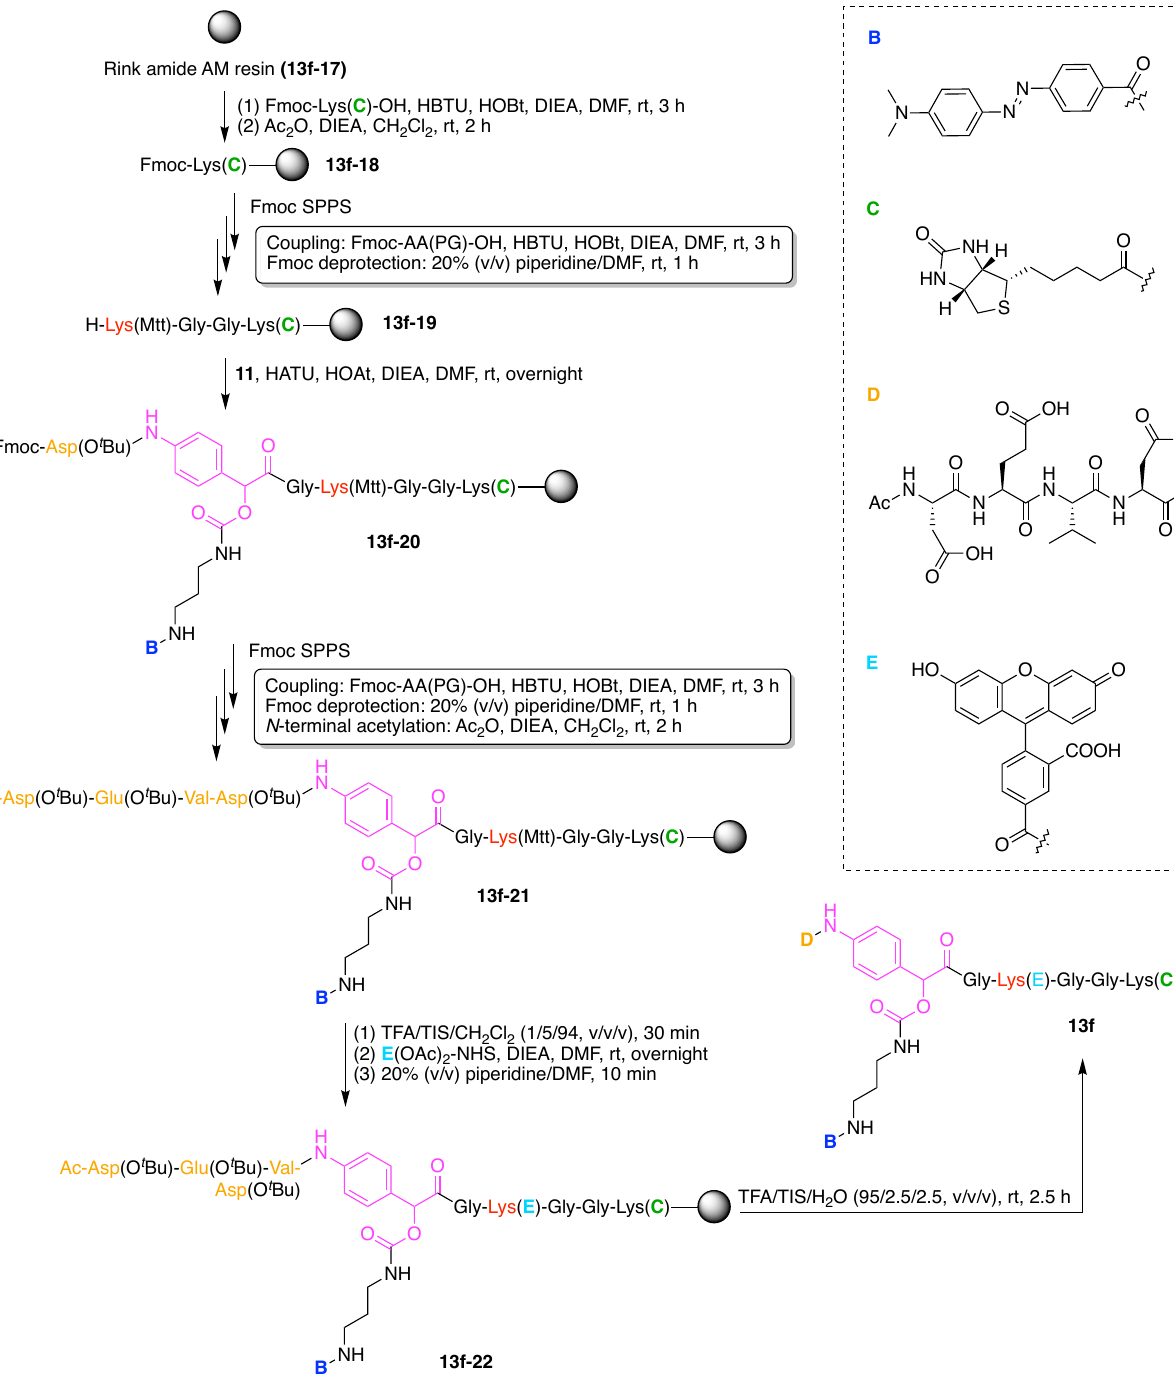
Figure 68. Synthesis of the qABP unit by Fmoc SPPS.